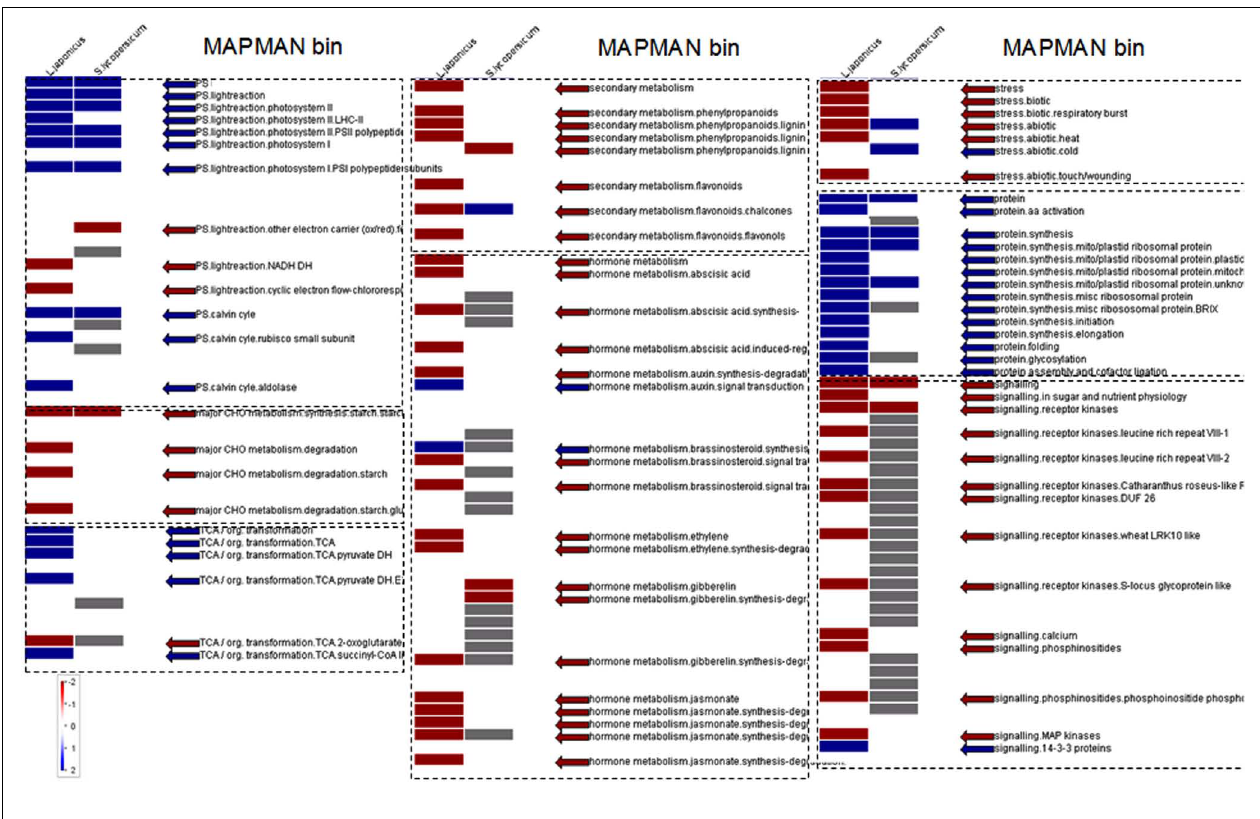
in R, and classed according to the MAPMAN classifications (Thimm et al., 2004; Usadel et al., 2005) and over-representation classification assessed viaWilcoxon rank sum test ( P < 0.05; Usadel et al., 2006). Red indicates a decrease whereas blue indicates an increase (see color